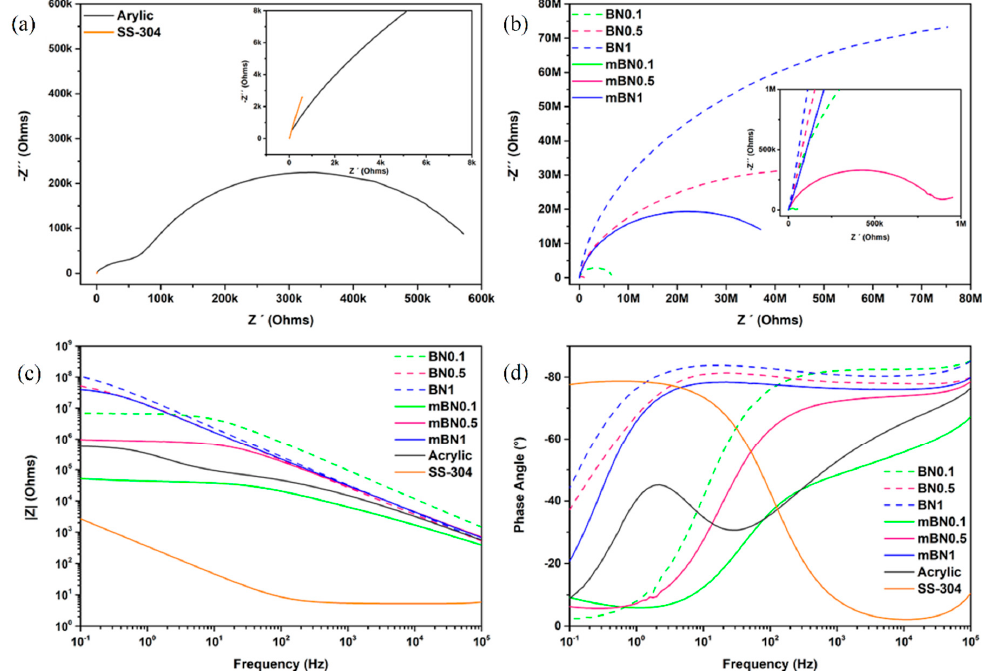
Figure 8. Nyquist plot for ( a ) acrylic resin and SS-304 and ( b ) formulations with nanoparticles; ( c ) Bode plots for phase angle vs. frequency and ( d ) impedance vs. frequency for di ff erent